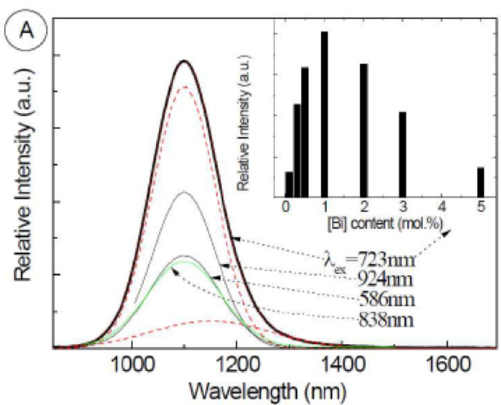
Figure 19. Near infrared emission spectra of Ba 2 P 2 O 7 :Bi excited at 586 nm, 723 nm (dotted lines: Gaussian peak fits), 838 nm, and 924 nm, respectively, and dependence of NIR emission intensity on nominal bismuth concentration (inset). Reprinted from [106] with permission.